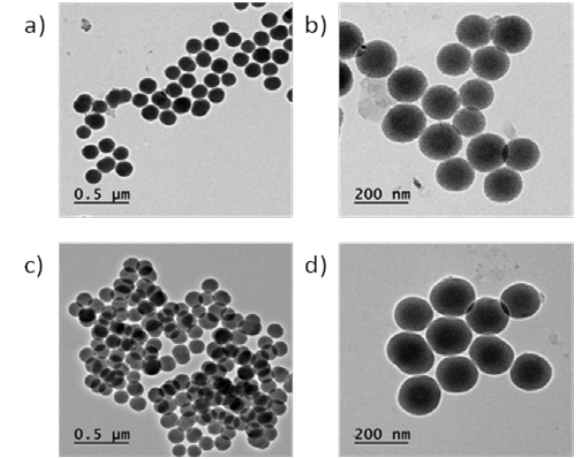
Figure 5. TEM images of silica nanoparticles, ( a , b ) mTPEP-SiO 2 and ( c , d ) pTPEP-SiO 2 .